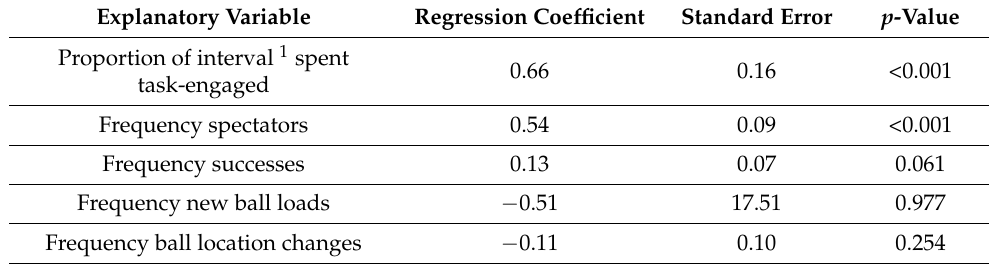
Table 3. GLM model